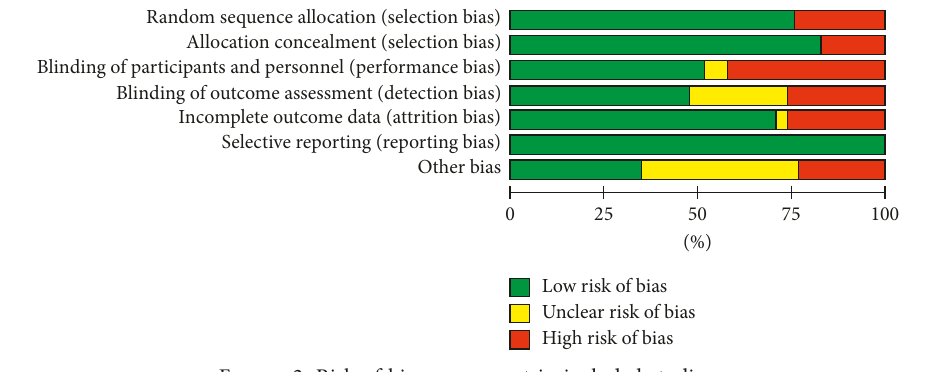
Figure 2: Risk of bias assessment in included studies. Table 3: Summary of regional techniques investigated in included